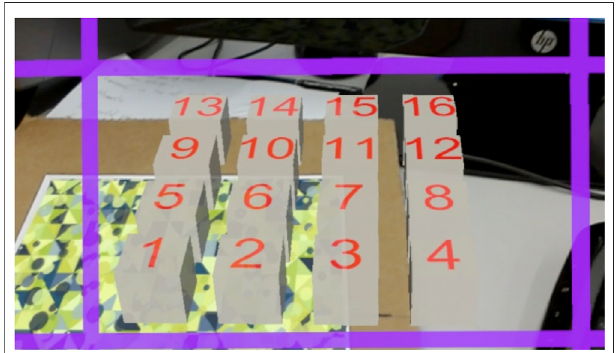
FIGURE 5 | We displayed purple stripes to illustrate the fi eld of view to participants. Thevirtual content insidetherectangleformed bythe fourstripes is what the viewer can see. Outside the rectangle, participants could see the realworld,but notthevirtualcubes. We designedthelayoutofthevirtual cubes such that the FOV from the seating positions was suf fi cient to see the whole set of cubes, minimizing the in fl uence of the limited